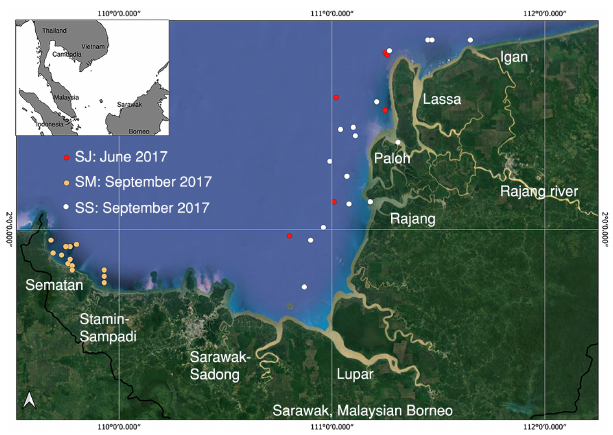
Figure 2. Map of the study area (©Google Maps), located in the southwestern part of Sarawak, Malaysia (inset). Indicators show the location of sampling sites used during field expeditions carried out in June and September